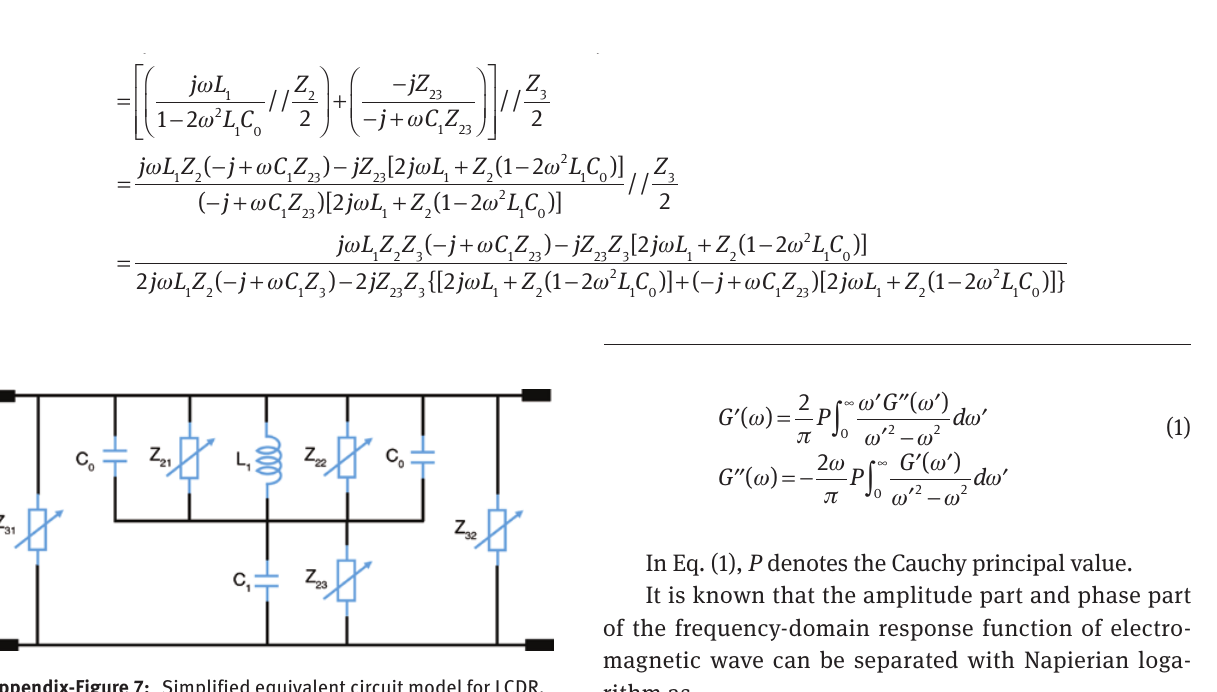
Appendix-Figure 7: Simplified equivalent circuit model for